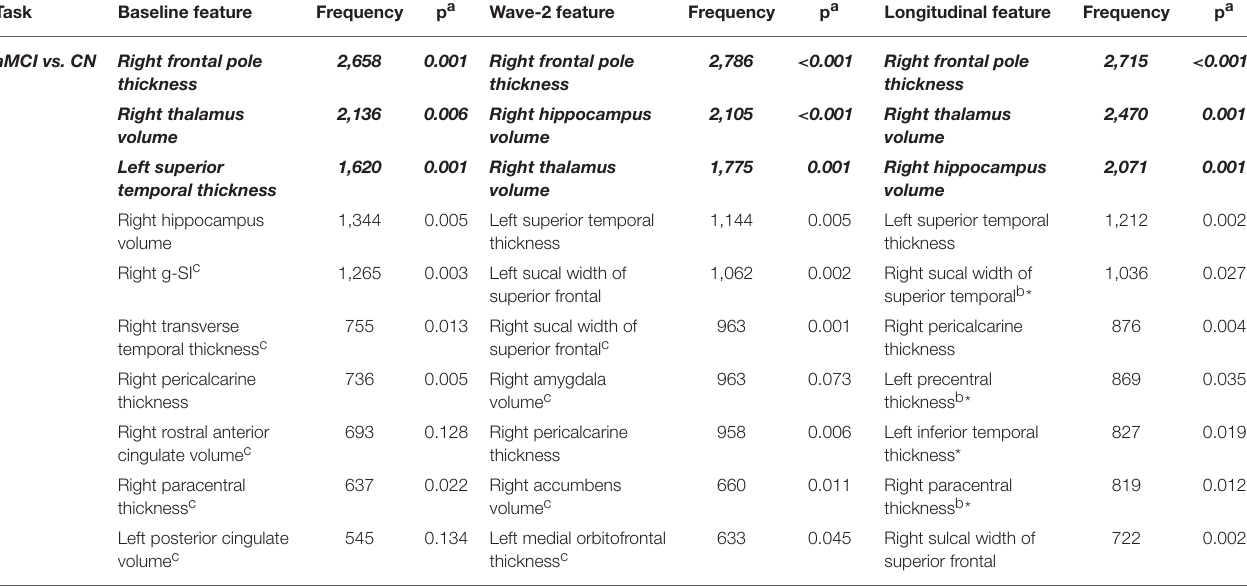
TABLE 3 | Selected features for the classification of aMCI vs. CN.